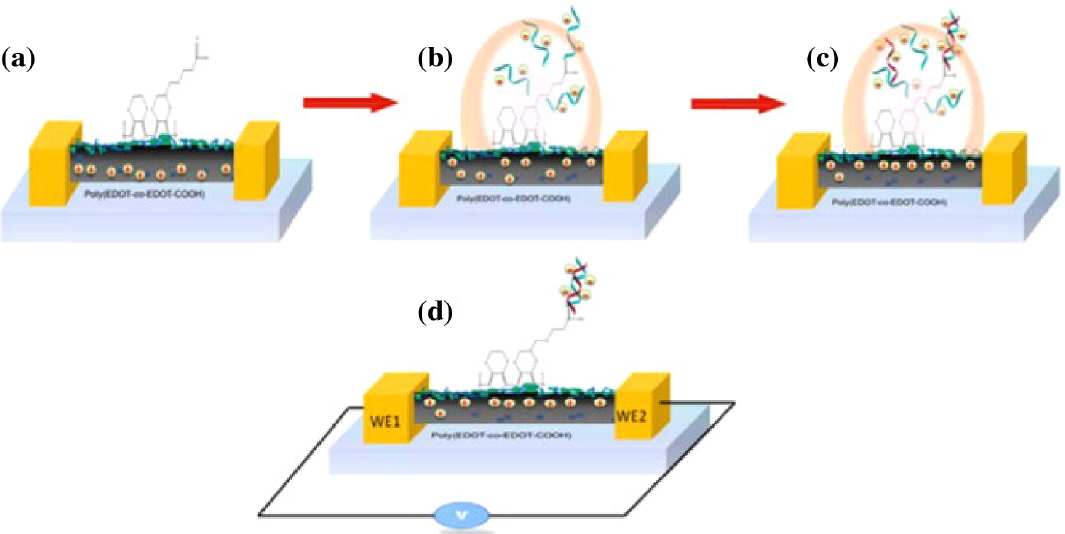
Figure 6. ( a ) Schematic of electrosynthesized nanowire with -COOH end groups for conjugation ( b ) with oligonucleotides (ODN) through EDC/NHS chemistry, ( c ) hybridization of target ODN, and ( d ) resistance measurement after drying of the wire. Reprinted from [52], Copyright 2012, with permission from Elsevier.